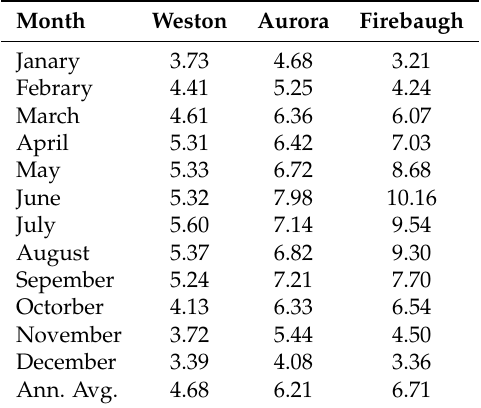
Table A3. The annual average DNI (kWh/m 2 /day) for each location is resolved by month. The data are calculated from the hourly TMY values obtained from